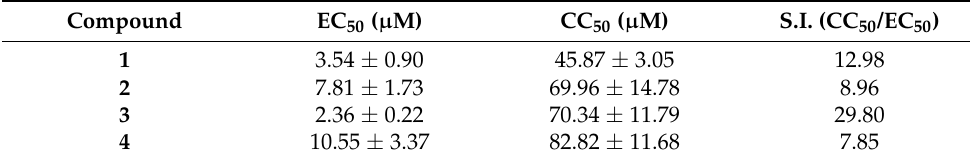
Errors were calculated from three independent